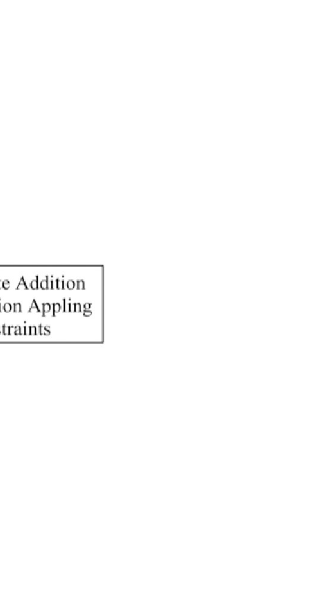
Fig 3. Bed finite element analysis